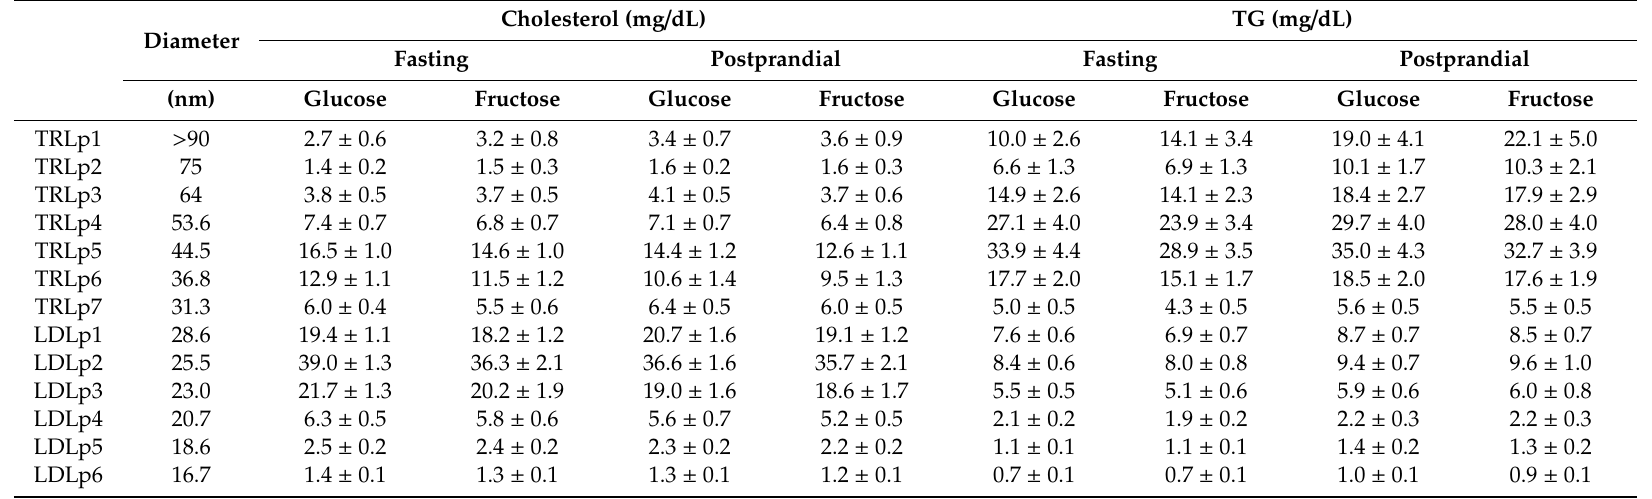
Table1. Baselinevaluesoffastingandpostprandialcholesterol(chol)andtriglycerides(TG)inTG-richlipoproteins(TRL)andlow-densitylipoprotein(LDL)subfractions. Cholesterol (mg / dL) TG (mg / dL) Diameter Fasting Postprandial Fasting Postprandial Glucose Fructose Glucose Fructose Glucose Fructose Glucose